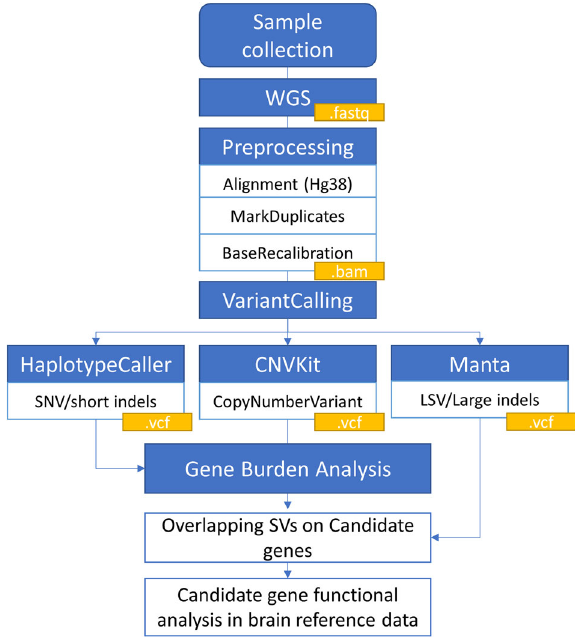
Fig. 3 Bioinformatic pipeline for analyses of genome sequencing datasets according to the type of variant (SNV/short indels, copy number variant or structural variants/ large indels). In detail, output format for each step fi le is described in yellow boxes, processing steps in blue boxes, and tools or methods used in white